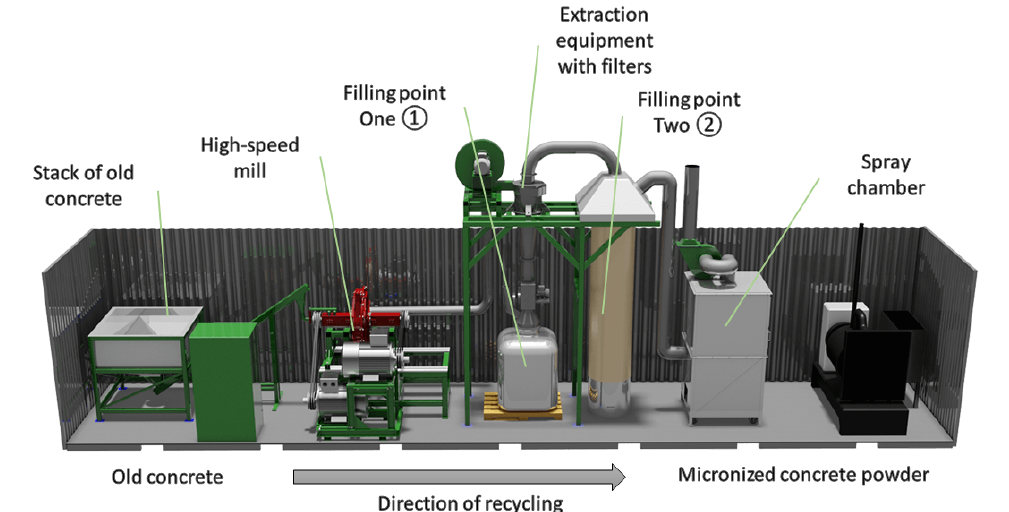
Figure 1. Recycling line with individual components and filing points.